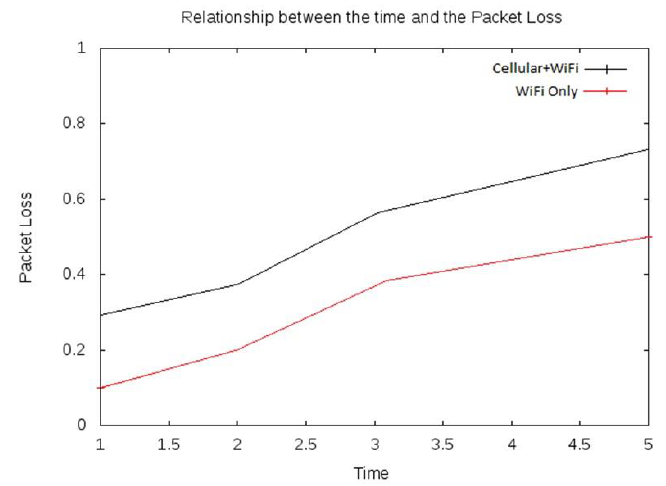
Figure 5. Time vs. packet